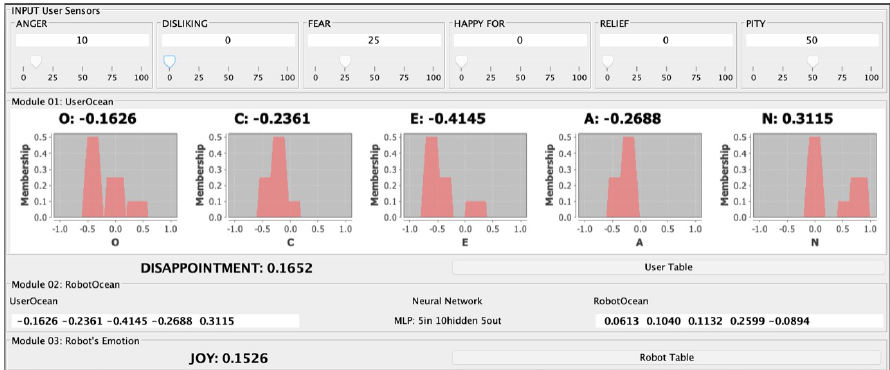
Figure 26. Example of an execution of the I2E